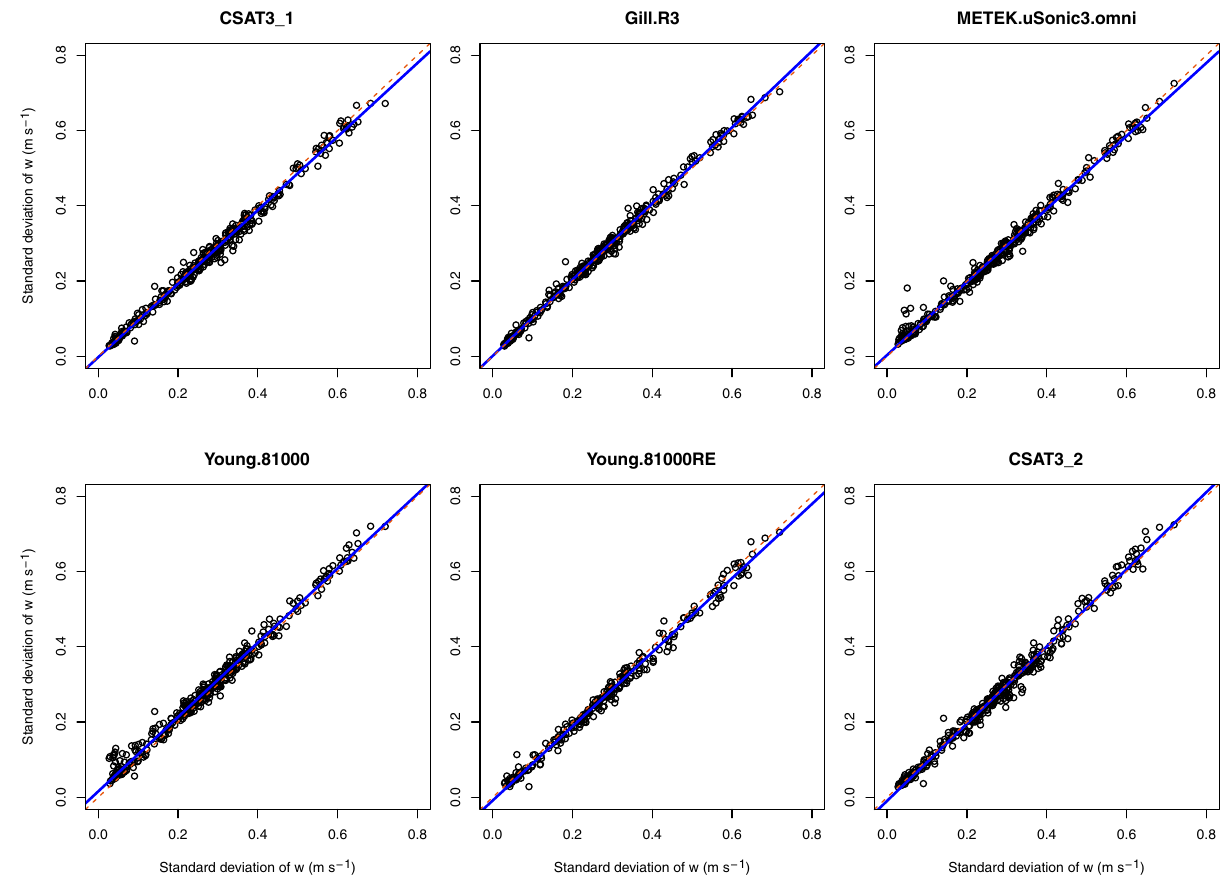
Figure 6. Comparison of the standard deviation of the vertical velocity component σ w (etalon = Gill.HS). Table 4. Regression results for the comparison of the standard deviation σ w , plus estimates for bias and comparability (RMSE). Etalon =